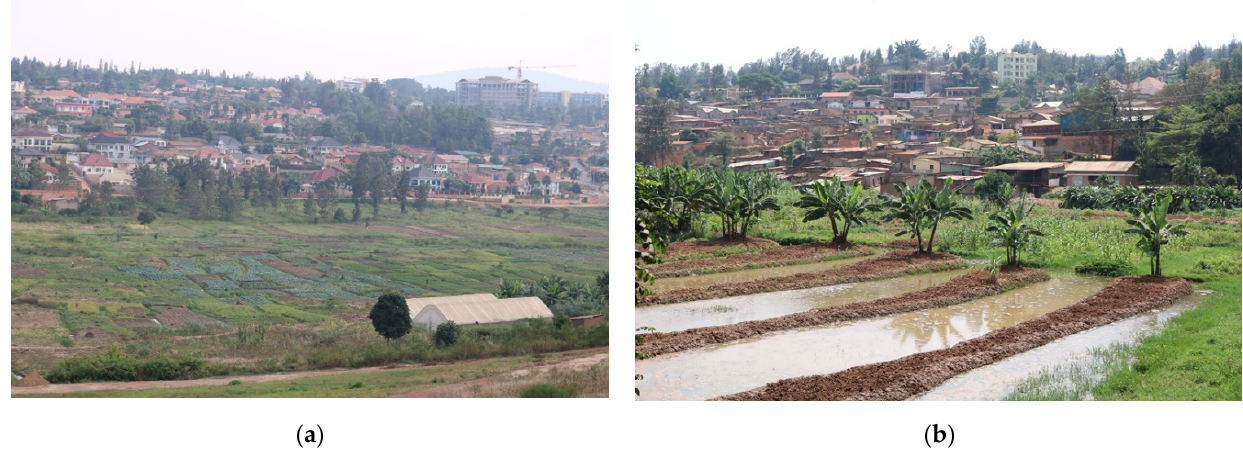
Figure 7. ( a ) Valley bottom divided into smaller cultivated plots in the Gasabo district, ( b ) rice plots in the valley on the border of Gasabo and Nyarugenge districts.